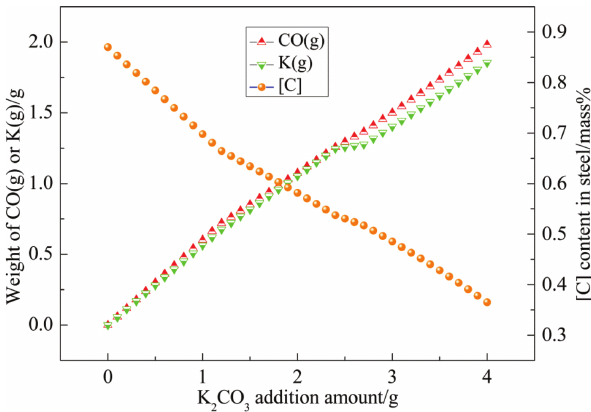
Figure 5: Composition changes of [C], CO(g) and K(g) with K 2 CO 3 addition calculated by FactSage.